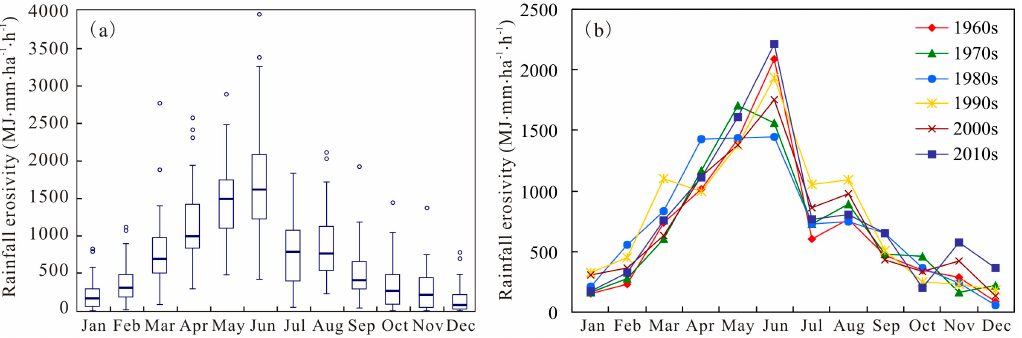
Figure 2. Intra-annual distribution of (a) monthly rainfall erosivity (b) average RE per 10 years during the period of 1960–2012.